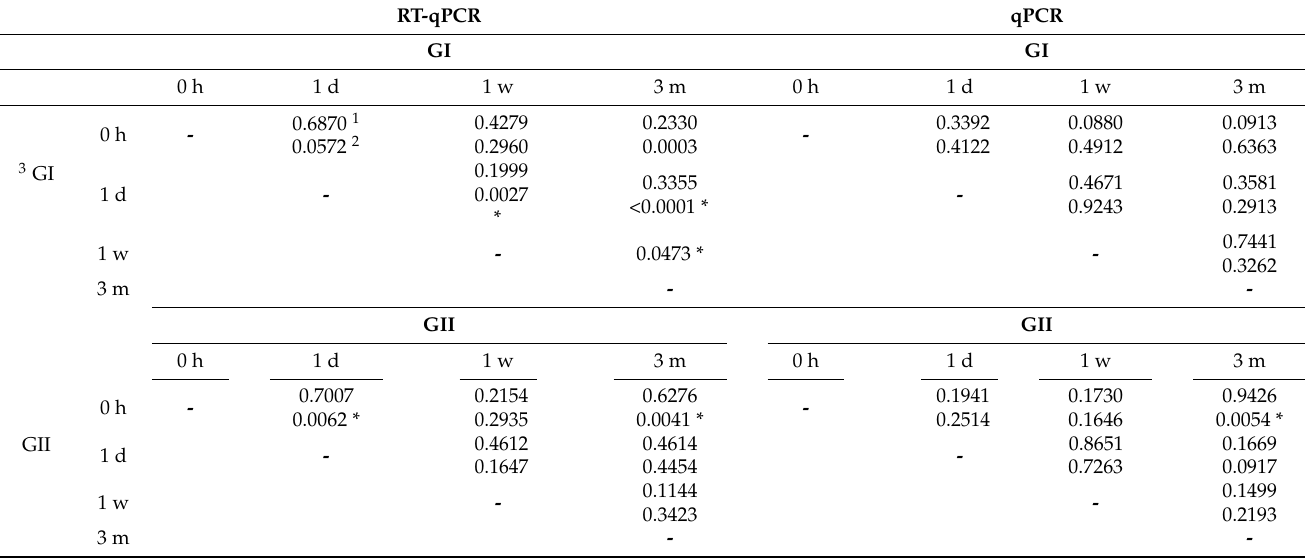
Table 2. Statistical analysis of the effect of storage times on the stability of the